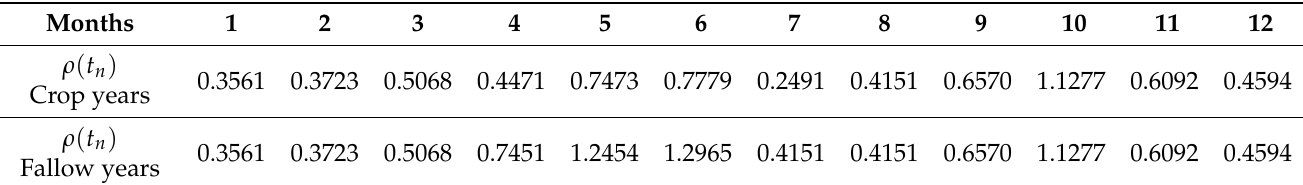
Table 2. Hoosfield spring barley experiment. Values of ρ per month, in crop and fallow years, estimated from clay content of 23.4%, water-related data in [3], and soil cover factors.